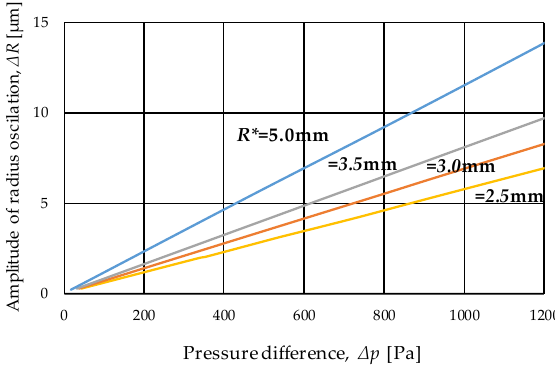
Figure 4. Amplitude of radial oscillation and pressure estimated by Equation (4).